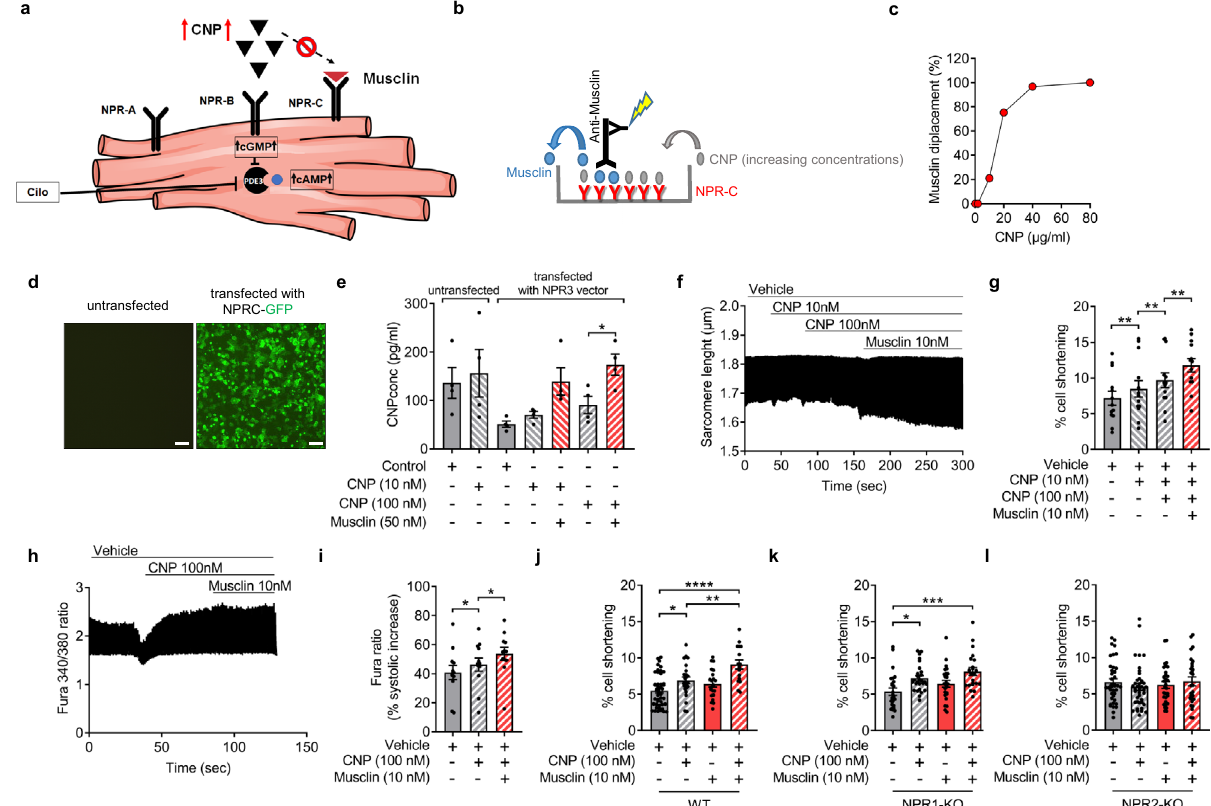
Fig. 5 Musclin augments cardiomyocyte contractility by enhancement of CNP/NPR-B signaling. a Scheme depicting the proposed mechanism of augmented cardiomyocyte contractility by Musclin. Scheme ( b ) and results ( c ) of the NPR-C/Musclin/CNP competition assay. Increasing levels